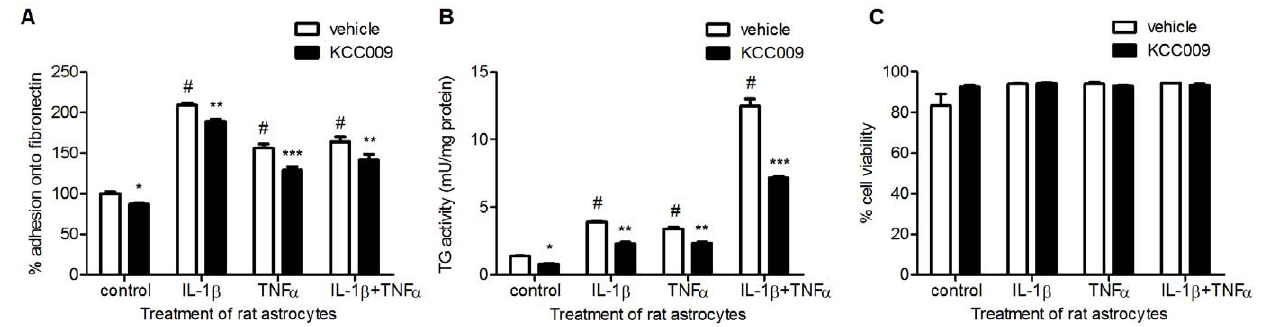
Figure 4. The effect of cytokine treatment and inhibition of TG2 activity on the adhesion capacity of astrocytes onto Fn. A ) Adhesion of rat astrocytes onto Fn coated wells after treatment with cytokines and subsequent inhibition of TG2 activity. B ) TG activity after treatment with cytokines and subsequent inhibition of TG2 activity. C ) Cell viability measured using the propidium iodide assay. Data are expressed as mean + s.e.m., n=15 (A) or n=5 per condition (B,C), # P , 0.001 versus vehicle-treated control cells and *P , 0.05, **P , 0.01, ***P , 0.001 versus vehicle-treated control or matched cytokine-treated cells.